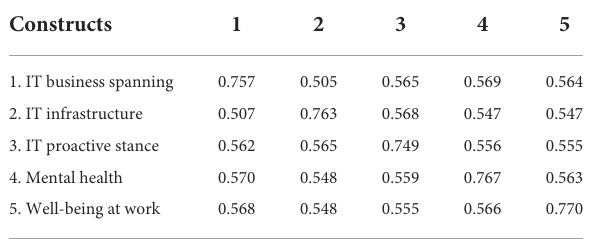
TABLE 3 Discriminant validity